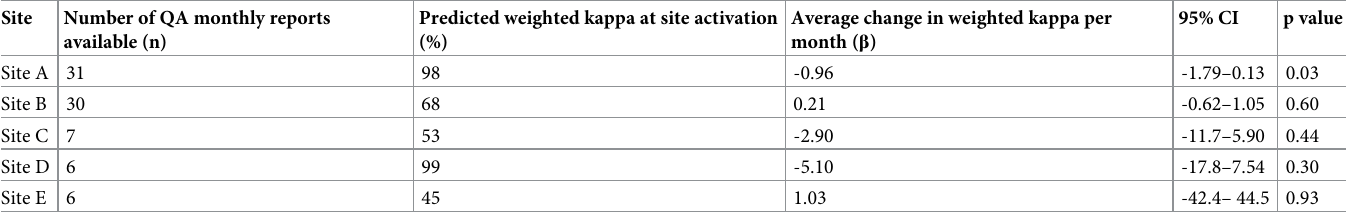
Table 5. Average change in weighted kappa estimate per month for five sites: